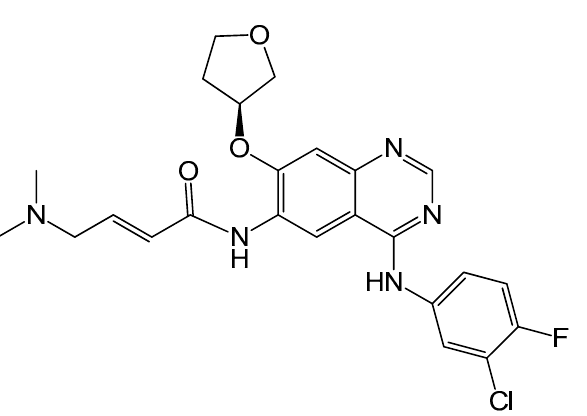
Figure 7. Chemical structure of afatinib, with the chemical formula C 24 H 25 ClFN 5 O 3 S and a molecular weight of 485.9384 g/mol.